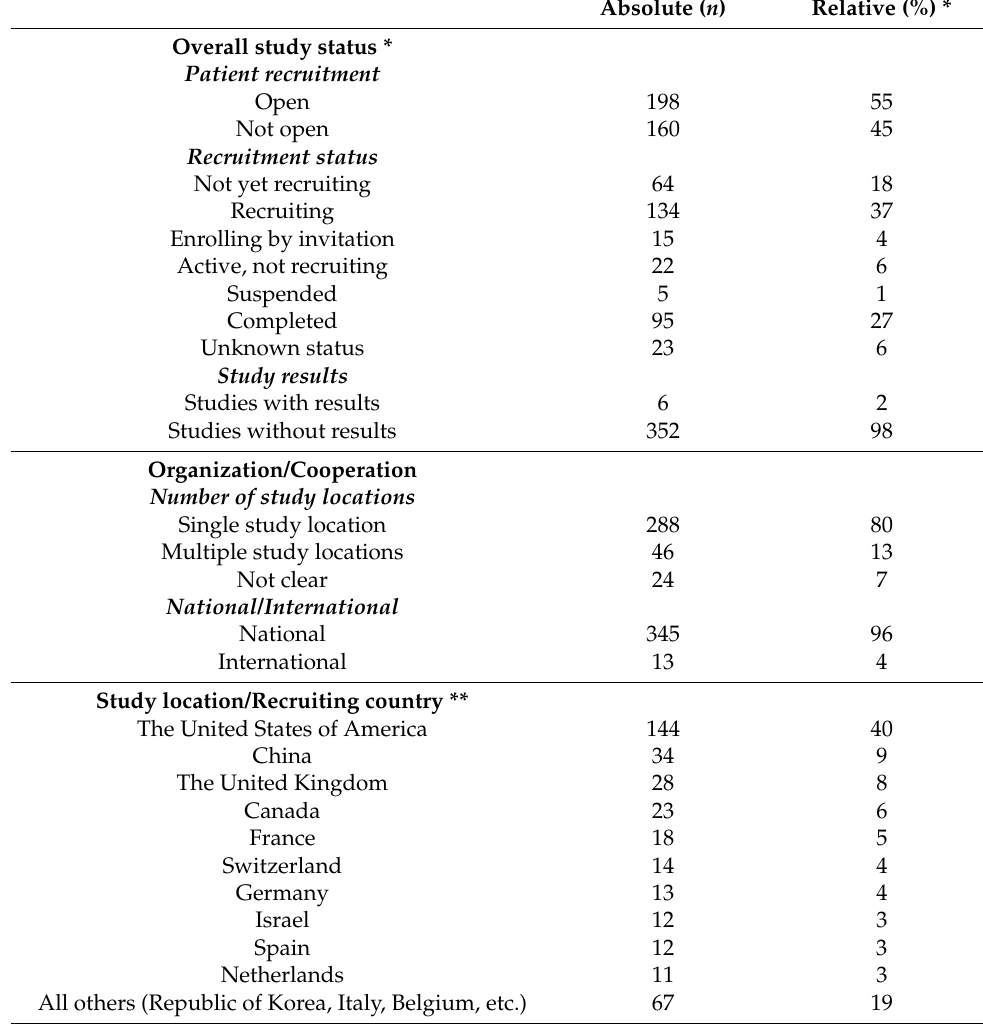
Table 1. Recruitment and organizational parameters of the included ML-related trials from the ClinicalTrials.gov registry ( n =